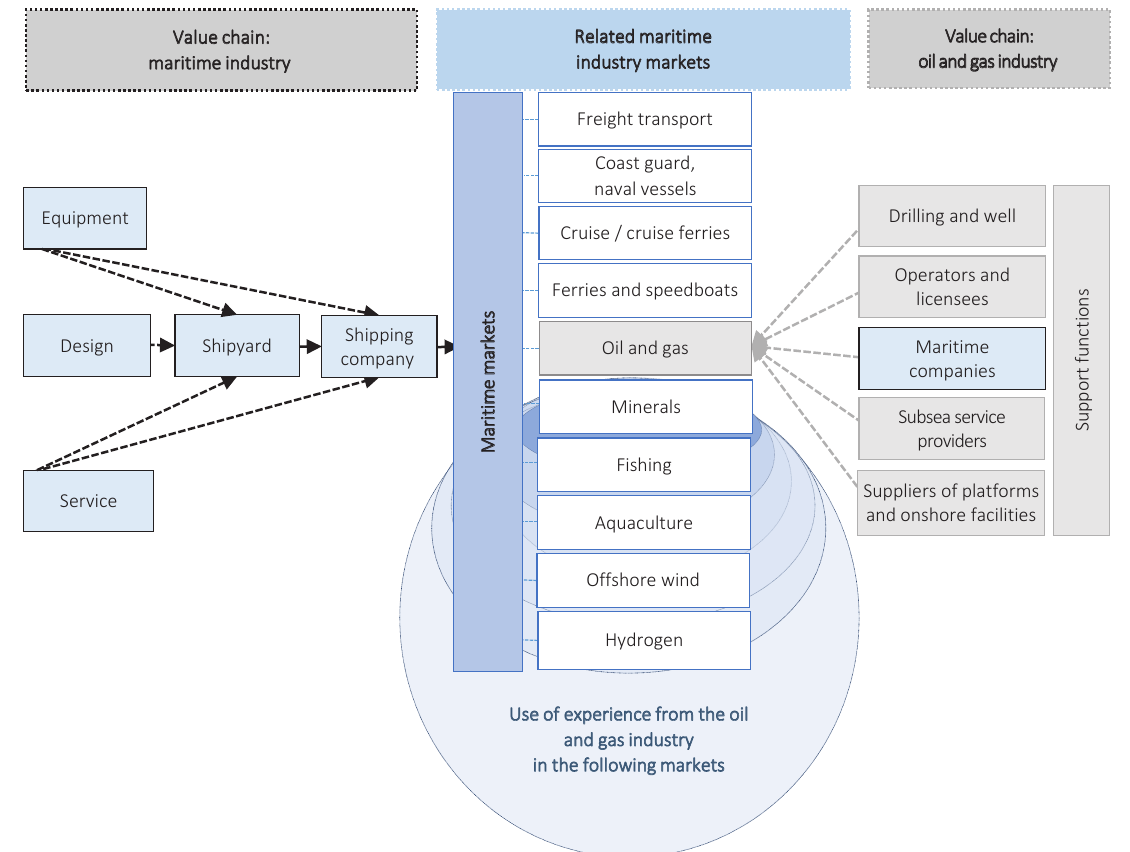
Figure 4. Interfaces in relationships within several